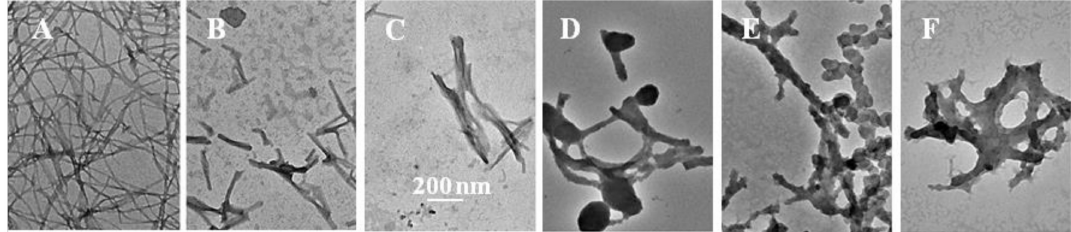
Figure 7. TEM images of insulin aggregates formed by incubating preformed fibrils (0.1 mM) at 37 ◦ C for 3 h in the absence ( A ) and presence of 0.8 mM AsA ( B ), AsA24h ( C ), AsA48h ( D ), DKG ( E ), and DHA ( F ).